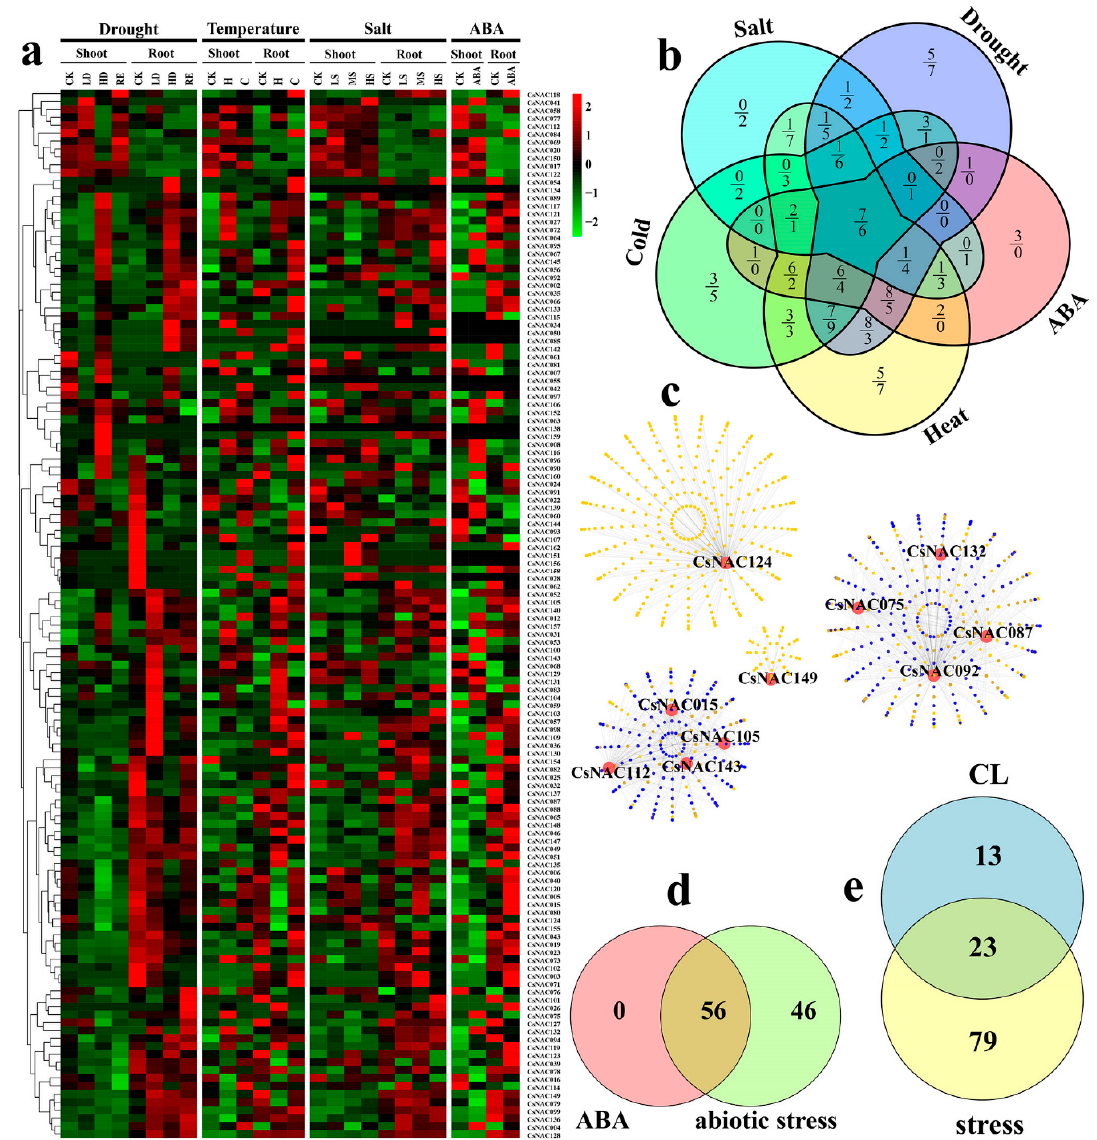
Figure 8. Expression profiles and coexpression network analysis of abiotic stress-associated CsNAC genes. ( a ) The expression profiles of CsNAC genes under five treatments (drought, heat, cold, salt and ABA). ( b ) The CsNAC DEGs under five treatments (high drought, heat, cold, high salt and ABA) were marked by the overlapping petal circle. The numbers above and below the line represent the CsNAC DEGs in shoots and roots, respectively. ( c ) Coexpression network of CsNAC genes with DEGs under abiotic stress. The light yellow points represent individual genes. The blue points represent overlapping genes. The dark yellow points represent yellow points overlying blue points. ( d ) The CsNAC DEGs under abiotic stress and ABA treatment was marked by the overlapping circle. ( e ) The CsNAC abiotic stress-associated and CL flowering-related genes were marked by the overlapping circle. CK: control; LD: low drought; HD: high drought; RE: recovery H: heat; C: cold; LS: low salt; MS: middle salt; HS: high salt.